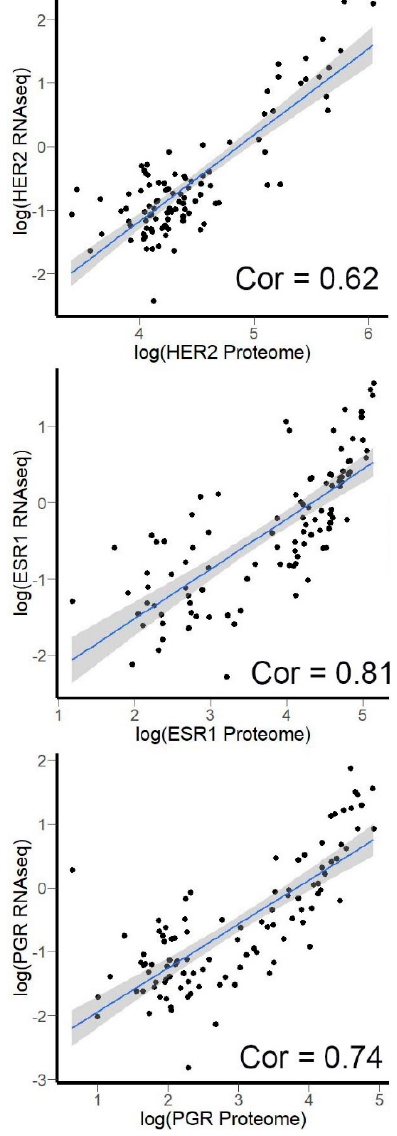
Figure 8. Proteomic results vs. mRNA level measured by NGS RNA sequencing in CPTAC data: ( A ) HER2: correlation coefficient (Spearman’s rho) = 0.62 ( p -value < 2.2 × 10 − 16 ); ( B ) ESR1: correlation coefficient (Spearman’s rho) = 0.81 ( p -value < 2.2 × 10 − 16 ); ( C ) PGR: correlation coefficient (Spearman’s rho) = 0.74 ( p -value < 2.2 × 10 − 16 ); Grey zone indicates 95% confidence interval for the trendlines. Cor—correlation coefficient.